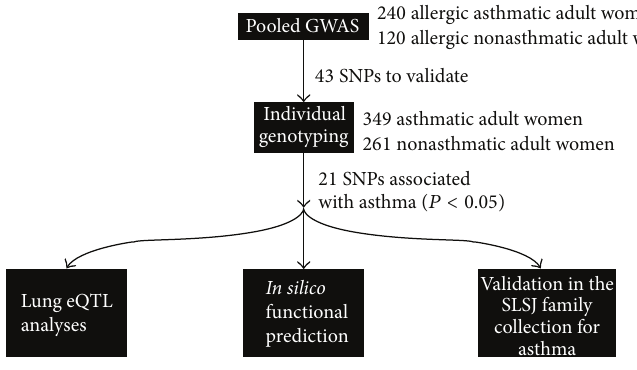
Figure 1: Overview of the experimental